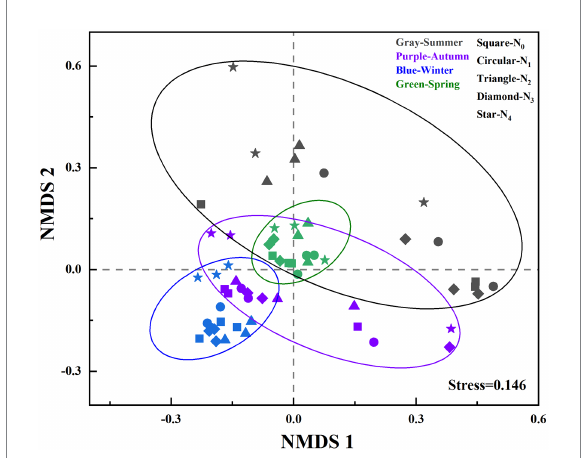
FIGURE 2 Nonmetric multidimensional scaling (NMDS) of seasonal changes in the soil AM fungal community compositions (based on Bray- Curtis distances and the presence of OTUs) in the poplar plantations under different nitrogen additions. N 0 , N 1 , N 2 , N 3 , and N 4 were 0, 5, 10, 15, and 30 gN·m − 2 ·a − 1 ,